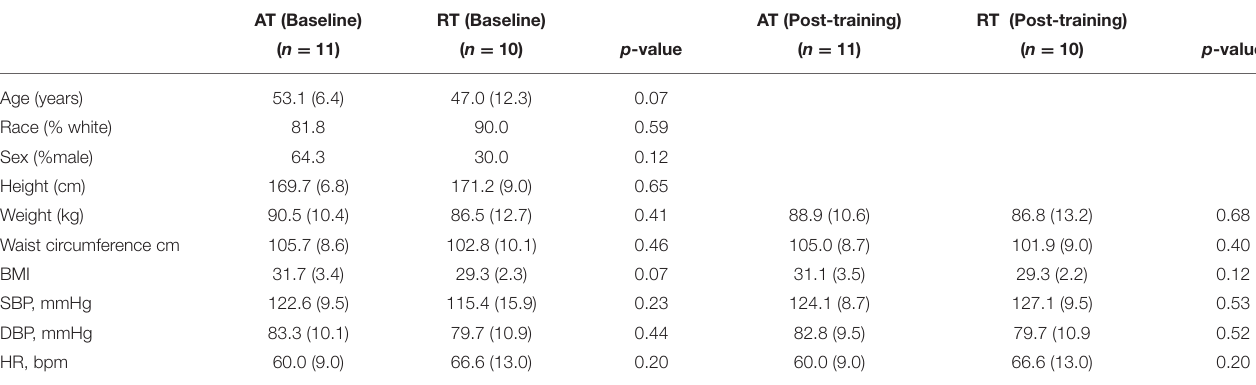
TABLE 1 | Aerobic Training (AT) and Resistance Training (RT) demographics. AT (Baseline) RT (Baseline) AT (Post-training) RT